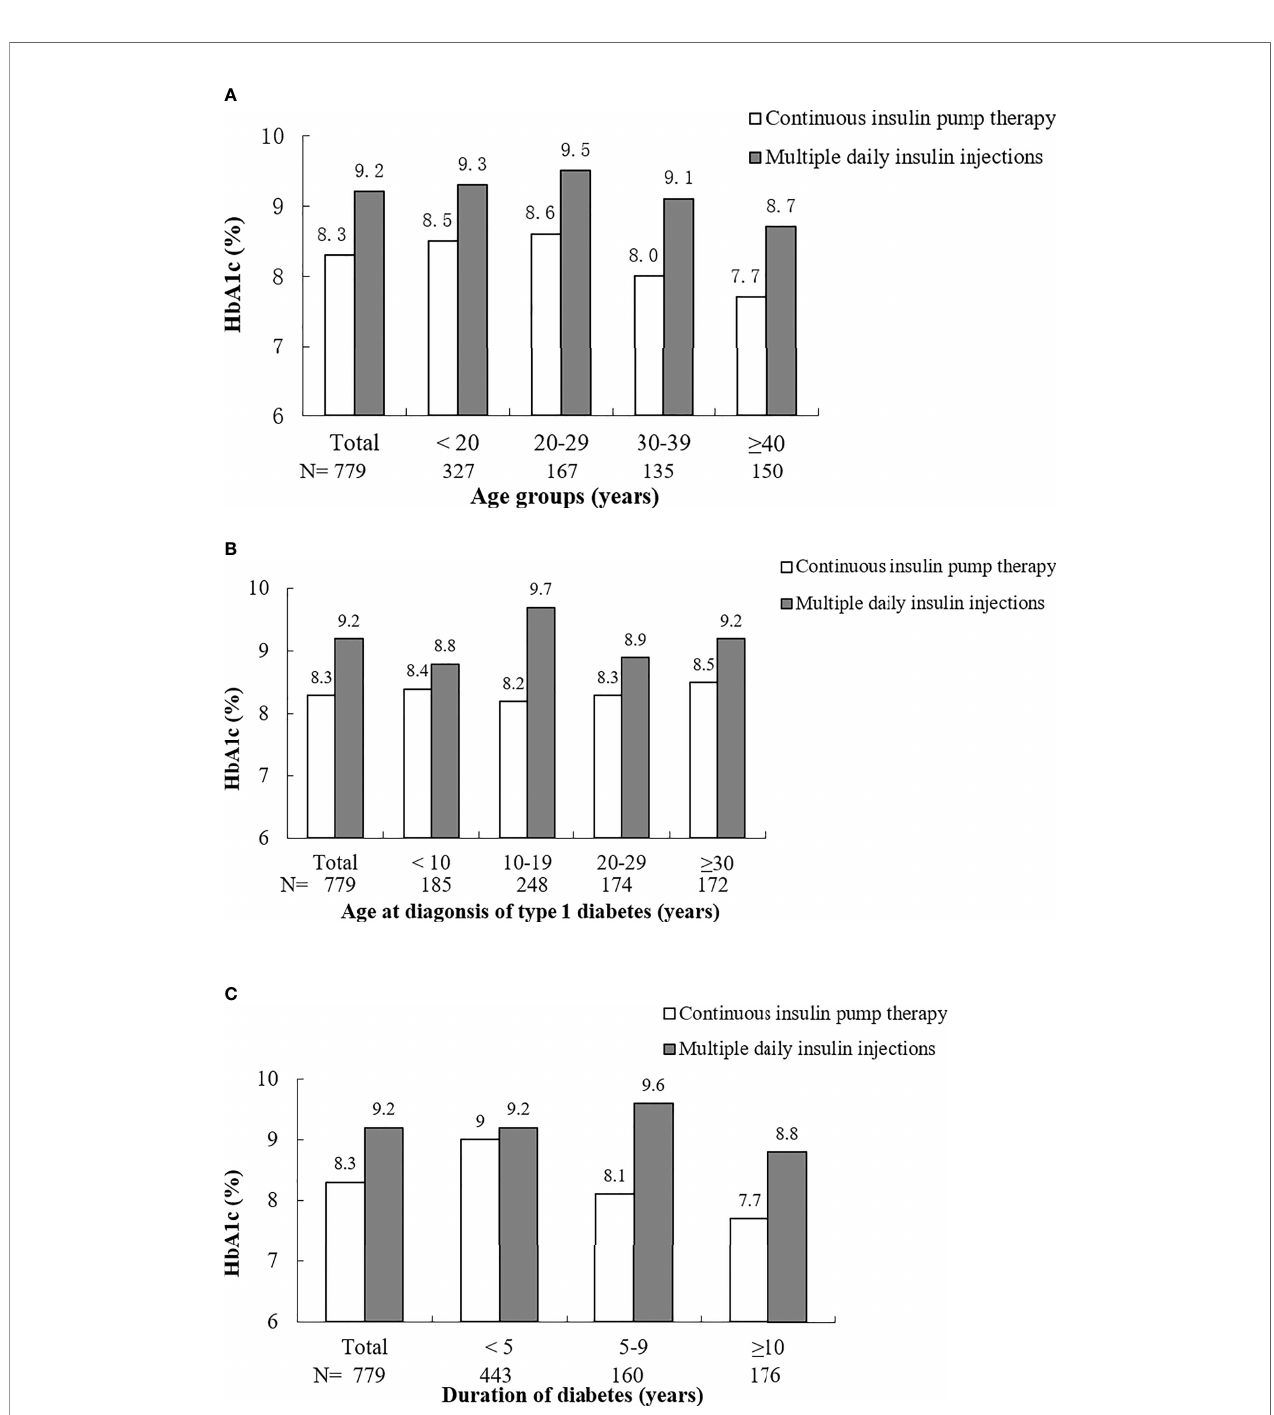
FIGURE 1 | HbA1c of patients with continuous insulin pump therapy and multiple daily insulin injections by groups of age (A) , age at diagnosis of type 1 diabetes (B) and duration of diabetes (C)